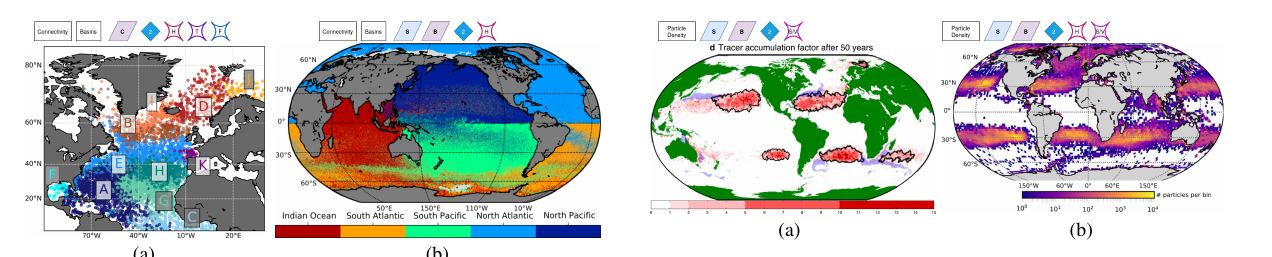
Figure 2. Basin connectivity - mapping initial to final locations. a) (Wichmann et al., 2020), fig. 6 (adapted), transparent glyphs. b) (Wichmann et al., 2019b), fig. 3c (adapted), dense scatter plot